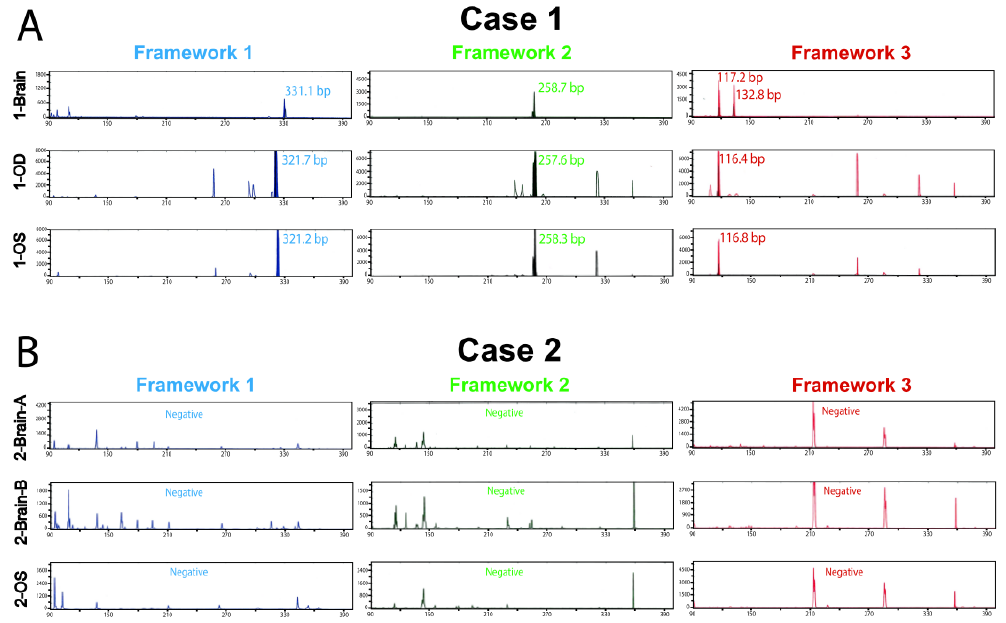
Figure 1. Clonality testing in brain and vitreous liquid biopsy lymphoma samples. DNA obtained from brain PCNSL FFPE tissue and vitreous fluid underwent clonal IGH rearrangement PCR testing covering ~90% of the most common rearrangements. Assays were run in duplicate with negative controls (one replicate shown per sample). Assay includes three rearrangement frameworks, 1 (blue), 2 (green), and 3 (red), the colors indicating different fluorophores used to detect the PCR amplicon. Samples containing clonal populations can show rearrangement product (peaks) in one or more frameworks. Clonal rearrangements were defined as peaks identical between replicates that were at least 2× higher than the third highest peak. Capillary electropherogram plots of band intensity over fragment length show a positive PCR result for IGH gene rearrangement in Case 1 ( A ) but not Case 2 ( B ).